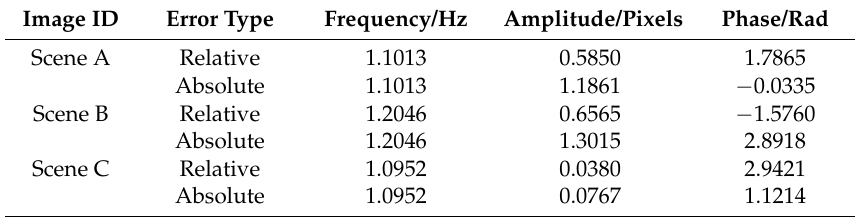
Figure 13. Refined parallax images across the track between B2 and B3 of ( a ) Scene A, ( b ) Scene B, and ( c ) Scene C. Table 7. Detected results using B2–B3 images